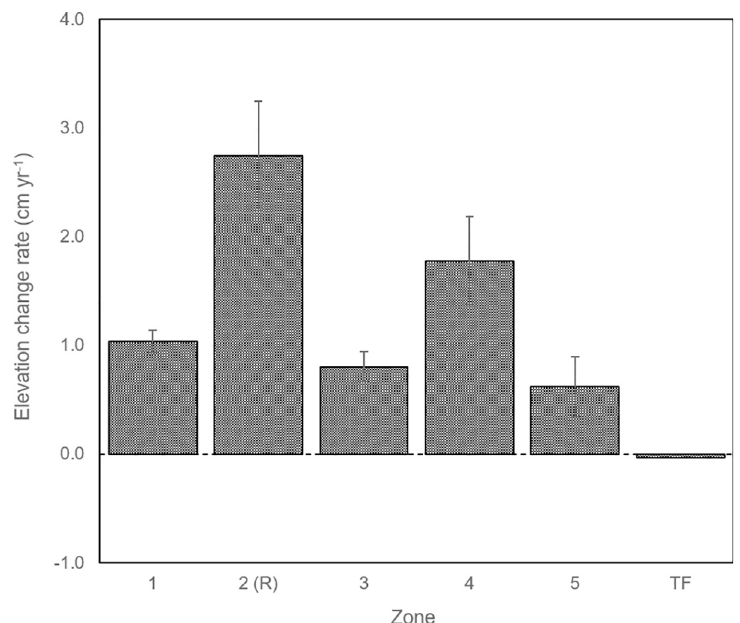
Fig 3. Mean rate of elevation change as measured by SETs and averaged by zone, for the entire period of record (2011–2018) with standard error bars. Zone 2 is the restored area, Zone TF is the tidal flat zone, and the remaining Zones 1, 3, 4, and 5 are natural marsh zones (see Fig 1 for a map showing the location of all